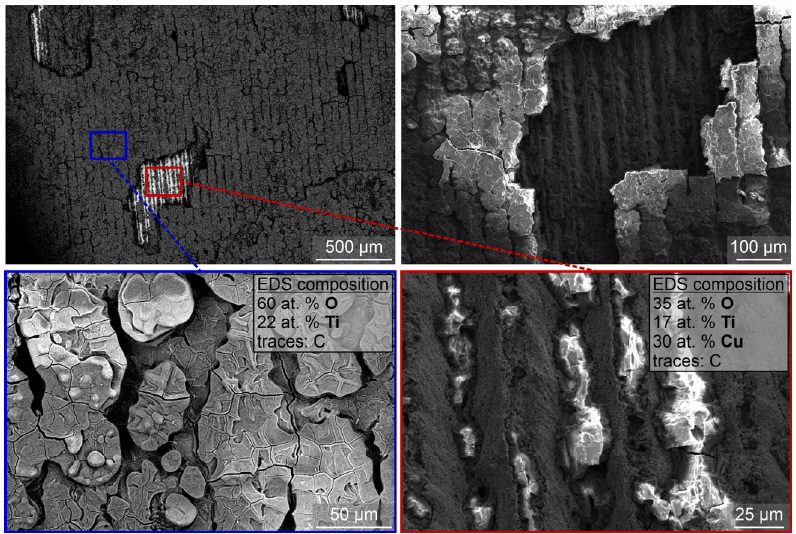
Figure 6. SEM images of the laser-textured sample LT after exposure to boiling 0.1 wt.% nanofluid with small nanoparticles (i.e., S-0.1). The boiling of nanofluid with larger nanoparticles (490 nm) was performed at 0.001 and 0.1 wt.%. Boiling curves at 0.001 and 0.1 wt.% are shown in Figure 7a,c, respectively, while the HTCs are shown in Figure 7b,d, respectively.